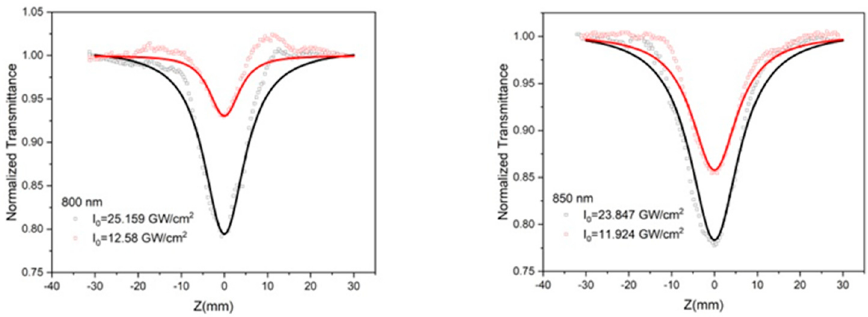
Figure 2. Femtosecond OA Z-scan experiments of ZL-22 at 800 nm and 850 nm. The dots represent experimental data and the lines represent theoretical fitted curves.